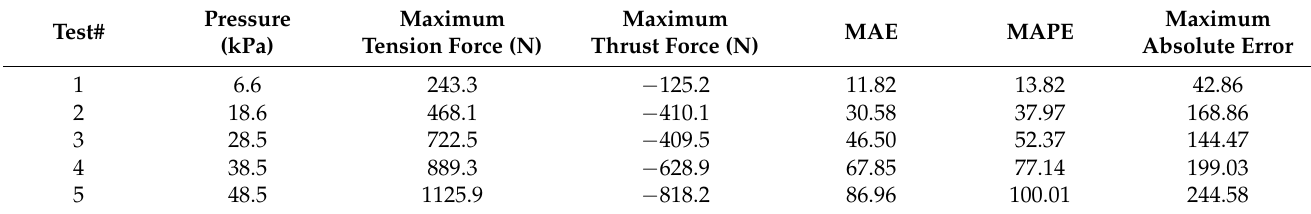
Table 3. Summary of the test data of the actuator with a machined